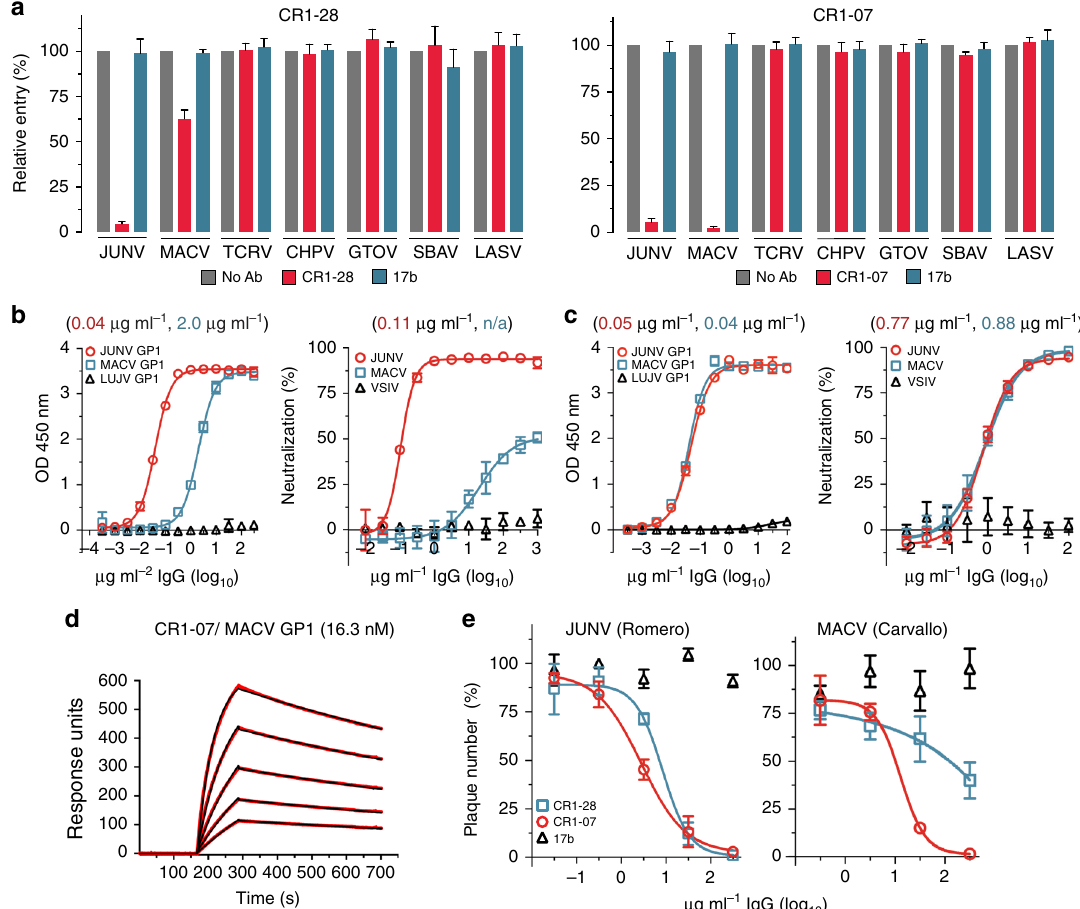
Fig. 2 Vaccine-elicited antibodies cross-neutralize Machupo virus. a Pseudotypes for the indicated arenaviruses were pre-incubated with monoclonal antibodies CR1-28 (left panel) or CR1-07 (right panel) at 100 µ g ml − 1 . Entry levels measured as in Fig. 1f. LASV pseudotype is included as a control. b Left: ELISA of CR1-28 binding to immobilized JUNV GP1 or MACV GP1. The calculated EC 50 value is shown in parentheses. LUJV GP1 is a control. Right: HEK293T cells were challenged with JUNV or MACV pseudotypes after pre-incubation with CR1-28 at the indicated concentrations. The calculated IC 50 value is shown in parentheses. VSIV pseudotype is included as a control. c Left: ELISA of CR1-07 binding to immobilized JUNV GP1 or MACV GP1. The calculated EC 50 value is shown in parentheses. LUJV GP1 is a control. Right: HEK293T cells were challenged with JUNV or MACV pseudotypes after pre- incubation with CR1-07 at the indicated concentrations. The calculated IC 50 value is shown in parentheses. VSIV pseudotype is included as a control. d Sensorgrams for binding of CR1-07 Fab binding to immobilized MACV GP1 as measured by surface plasmon resonance. The recorded sensorgrams (one of duplicates) are shown. The calculated K D value is shown in parentheses. e Left: Percent plaque number (relative to a no antibody control) for infectious JUNV (Romero strain) with CR1-28 or CR1-07 at the indicated concentrations. Right: Percent plaque number (relative to a no antibody control) for infectious MACV (Carvallo strain) with CR1-28 or CR1-07 at the indicated concentrations. 17b is an HIV-1 neutralizing monoclonal antibody used as control. Error bars indicate S.D. (for some data point, error bars are smaller than symbols). For ELISAs, the experiment was performed twice in duplicate, and representative data are shown. For pseudotype neutralization studies, data are averaged from two independent experiments performed in duplicate. For studies with authentic viruses, the experiment was performed once in